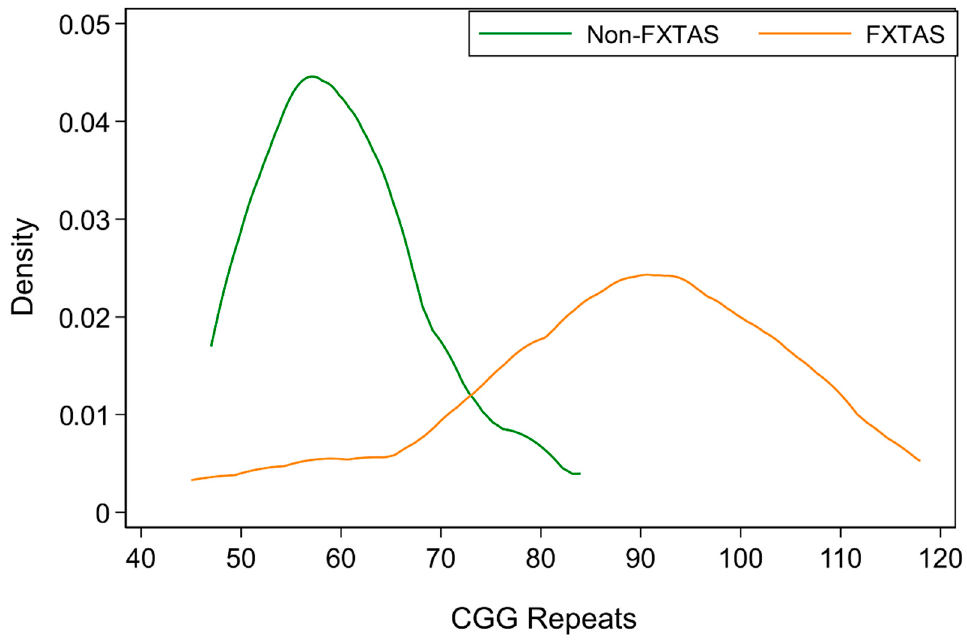
Figure 1. Kernel distribution of the CGG repeat expansion size in 23 male PM carriers affected with FXTAS against this distribution for 17 carriers in the non-FXTAS category.